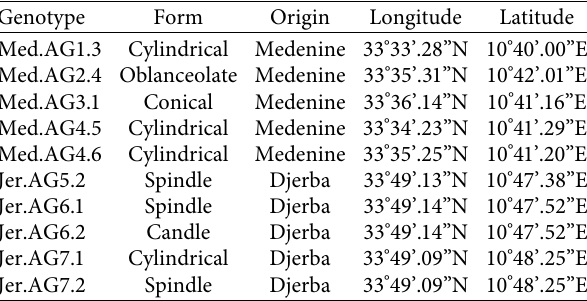
Table 1: The 10 P. glaucum genotypes and their location of col- lection with geographic